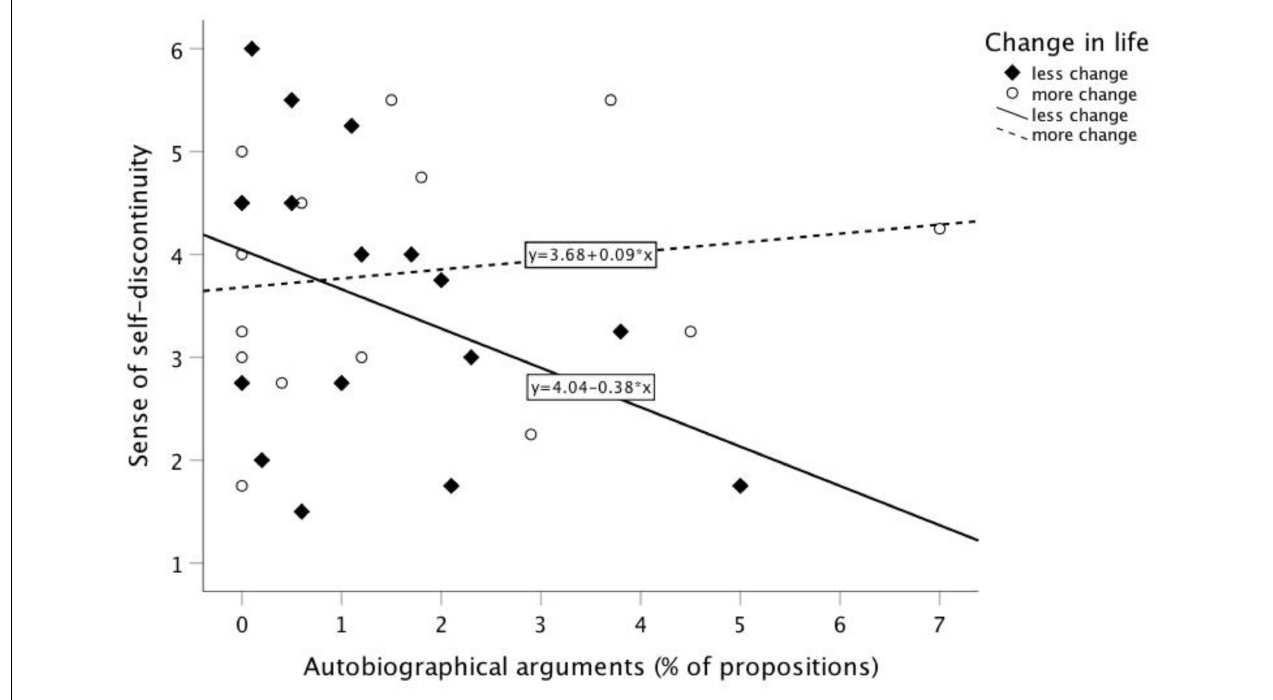
FIGURE 1 | Scatterplot of proportion of autobiographical arguments in life narratives with sense of self-discontinuity by groups of objective change in life since displacement.